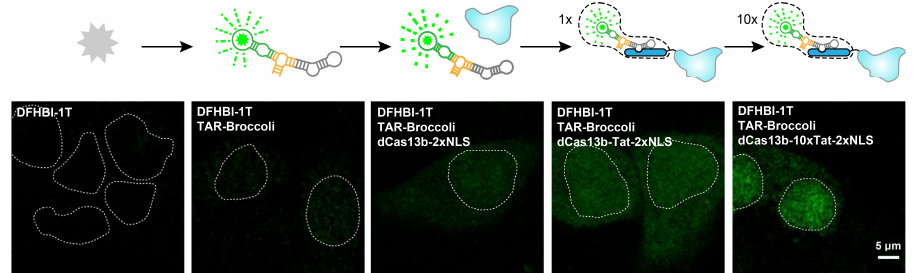
Figure 1. Verification of the feasibility of the CRISPR-TRAP-tag (CRISPR-Cas and Tat peptide with a fluorescent RNA aptamer) in live cells. Top, schematic of the CRISPR-TRAP-tag system to amplify the signal. Bottom, images of CRISPR-TRAP-tag in the 293T cells. First column, negative control. Second column, pTAR-Broccoli were transfected to the cells. Third column, the cells were co-transfected with pdPspCas13b-2 × NLS and pTAR-Broccoli. Fourth column, the cells were co-transfected with pdPspCas13b-Tat-2 × NLS and pTAR-Broccoli. Fifth column, the cells were co-transfected with pdPspCas13b-10 × Tat-2 × NLS and pTAR-Broccoli. The cell was treated with DFHBI-1T (10 µ M) before imaging. Scale bar, 5 µ m. The nucleus was dyed by DAPI (not shown), and the outline was illustrated as a dashed